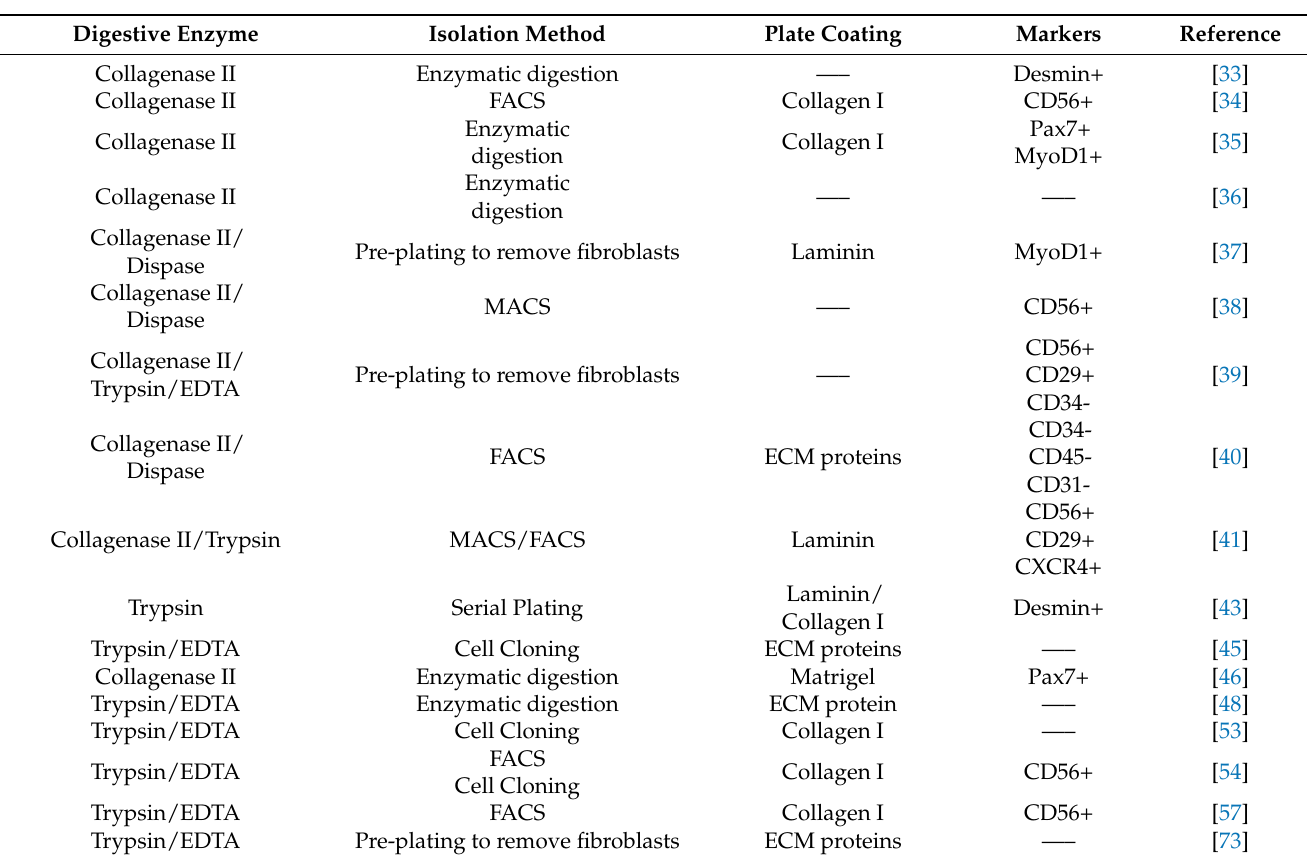
Table 1. Different methodologies to establish, isolate, and characterize hSCs from skeletal muscle biopsies. Digestive